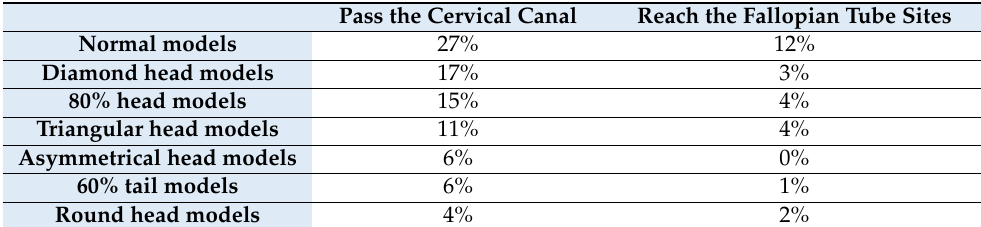
Table 1. Percentages of the normal and abnormal sperm models passing through the cervical canal (left column) and reaching the fallopian tube site (right